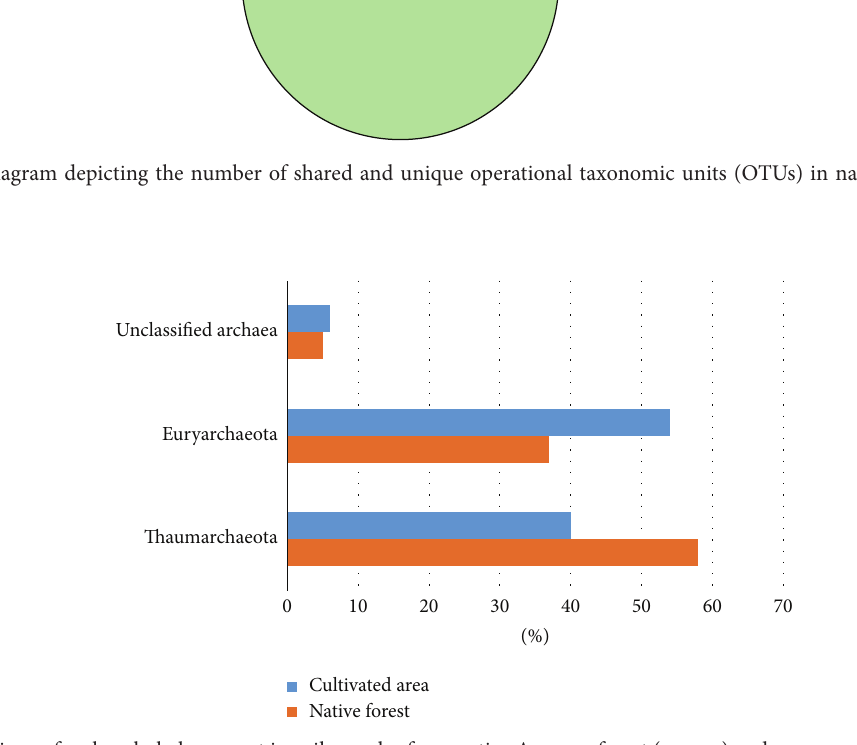
Figure 3: Comparison of archaeal phyla present in soil samples from native Amazon forest (orange) and an area under oil palm cultivation (blue). The percentages of unclassified sequences are